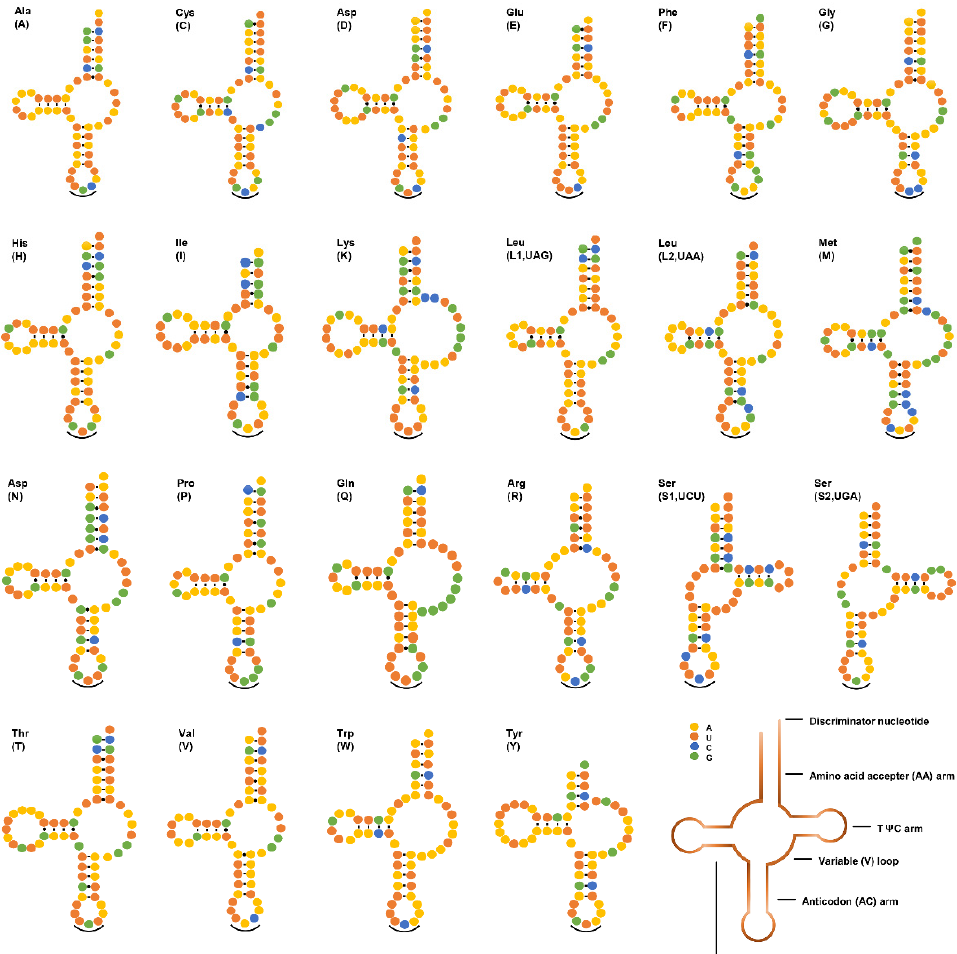
Figure 4. Secondary structures of 22 tRNAs in V. eleguneniensis mtDNA. All tRNAs are differed with their corresponding amino acid abbreviations. Each base is represented by a different colored circle, yellow for adenine (A), orange for uracil (U), green for guanine (G), and blue for cytosine (C). Normal base pairings are illustrated by lines (-), whereas non-standard base pairs are illustrated by dots ( · ). Anticodons are marked by black curved lines ( ‿ ).